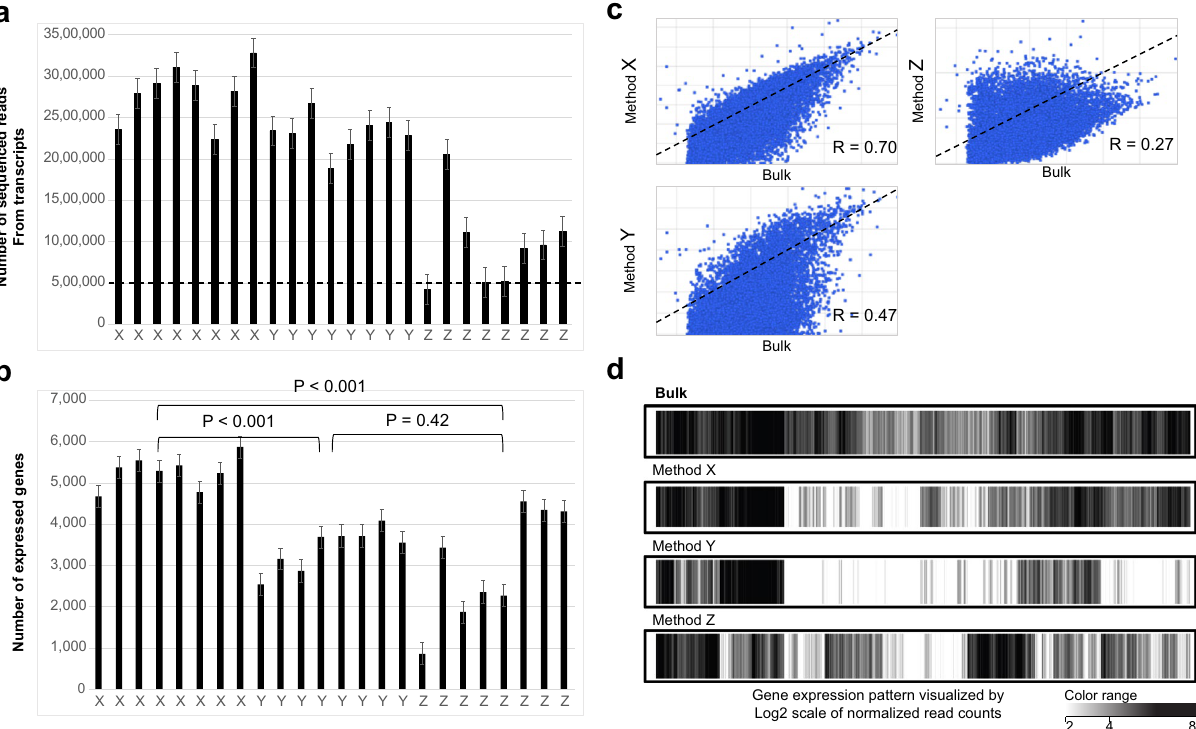
Figure 4. Performance of NGS in WTA sample. ( a ) Numbers of sequenced reads from transcripts in WTA samples by each method. The number of sequenced reads by method Z (MDA-based) was much lower than those of the other methods (PCR-based). However, most expressed genes in single cell can be detected with 0.5 × 10 6 reads and almost all samples yielded over 0.5 × 10 6 reads from transcripts. ( b ) Numbers of expressed genes in WTA samples by each method. We defined transcripts with over 100 sequenced reads as expressed genes. The number of expressed genes was comparable between each sample, and method X (PCR-based) amplified higher number of expressed genes compared to the other methods. ( c ) Scatter plot of normalized read counts of expressed genes in the bulk sample and WTA samples by each method. Sequenced reads from transcripts were normalized by DESeq and correlation analysis of the gene expression patterns between the bulk sample and WTA samples was performed by Spearman’s test. The samples by method X (PCR-based) correlated well with the bulk sample compared to the other methods (R = 0.70). ( d ) Gene expression patterns in the bulk sample and WTA samples by each method. According to scatter plot, the gene expression patterns of the samples by method X resembled those of the bulk sample. In contrast, samples by method Z (MDA-based) showed non-specific gene expression